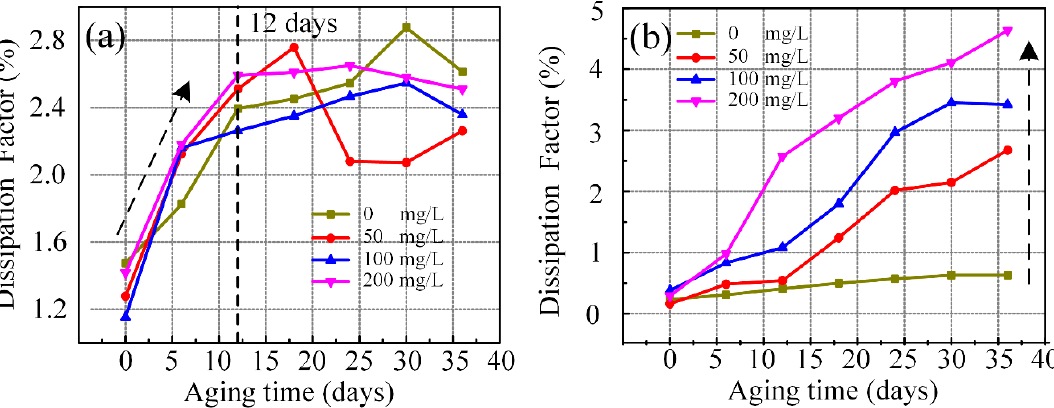
Figure 6. The variation of dissipation factor with C 60 concentration of aging vegetable insulating liquid ( a ) and aging mineral liquid ( b ).